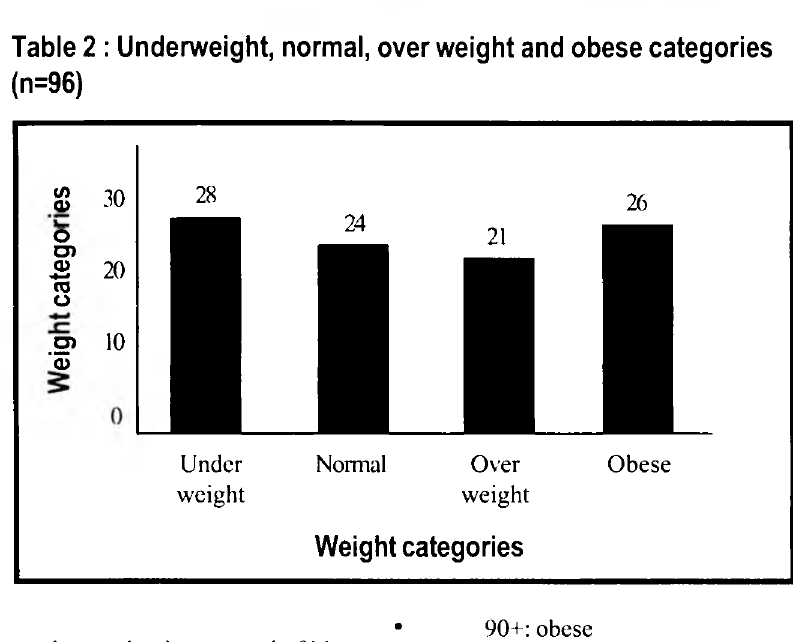
Table 2 : Underweight, normal, over weight and obese categories